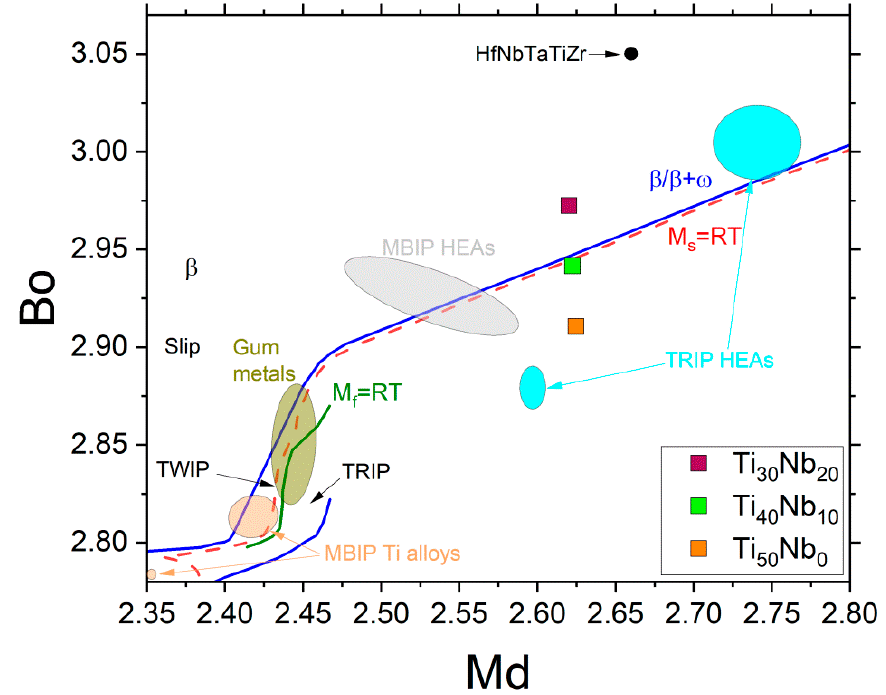
Figure 8. Positions of the program alloys on the Bo–Md map. The references used for plotting this map can be found elsewhere [39].